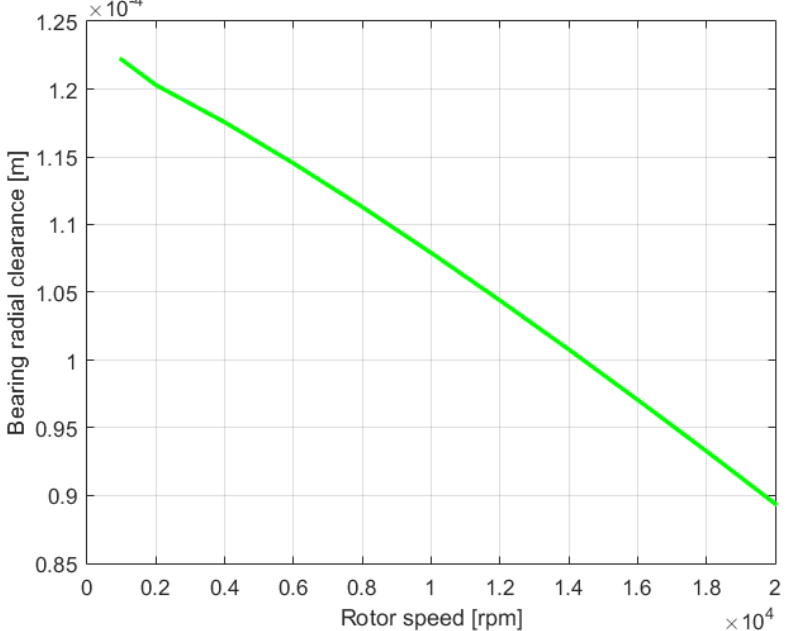
Figure 13. Bearing radial clearance variation obtained with the TEHD model for the NDE bearing, calculated by performing an average on the five pads. The variation of the radial clearance is expressed as a function of the rotor rotational